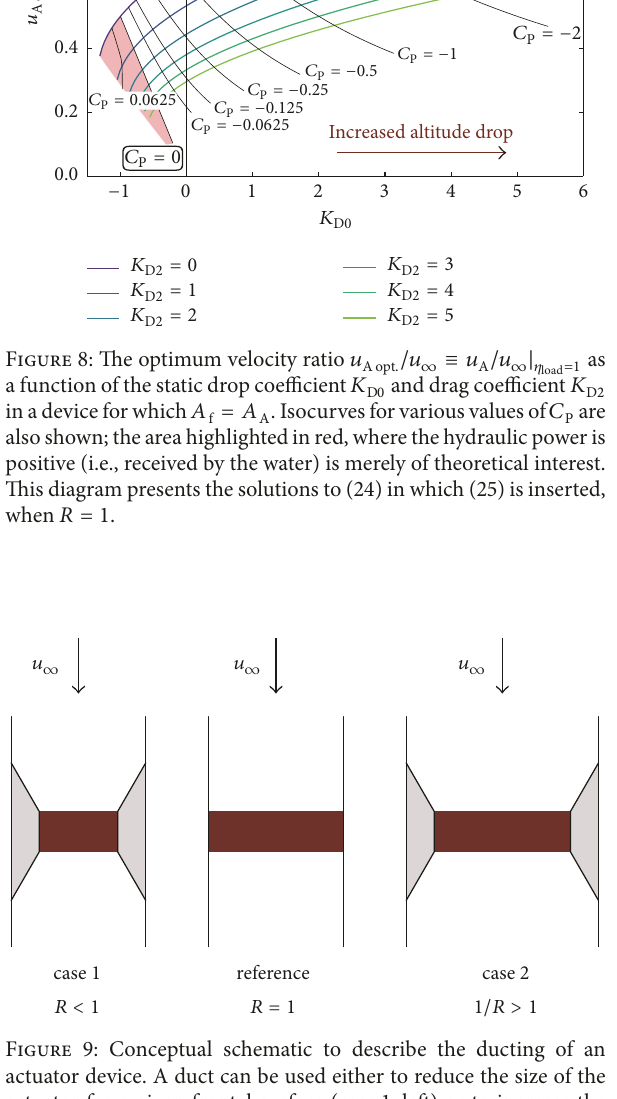
Figure 9: Conceptual schematic to describe the ducting of an actuator device. A duct can be used either to reduce the size of the actuator for a given frontal surface (case 1, left) or to increase the frontal area of a machine with an existing actuator (case 2, right). Both processes are described mathematically by reducing the value of parameter 𝑅 below